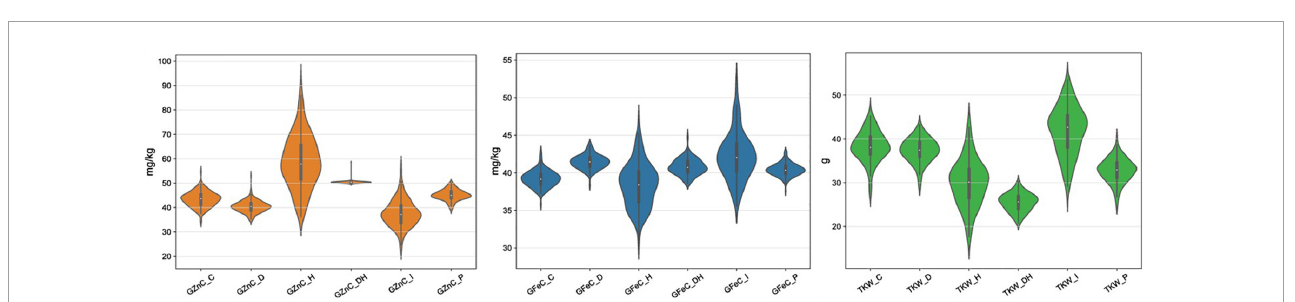
FIGURE1 Depiction of the distribution of GFeC, GZnC, and GZnC under control, drought, heat, and combined stress conditions through violin plots.